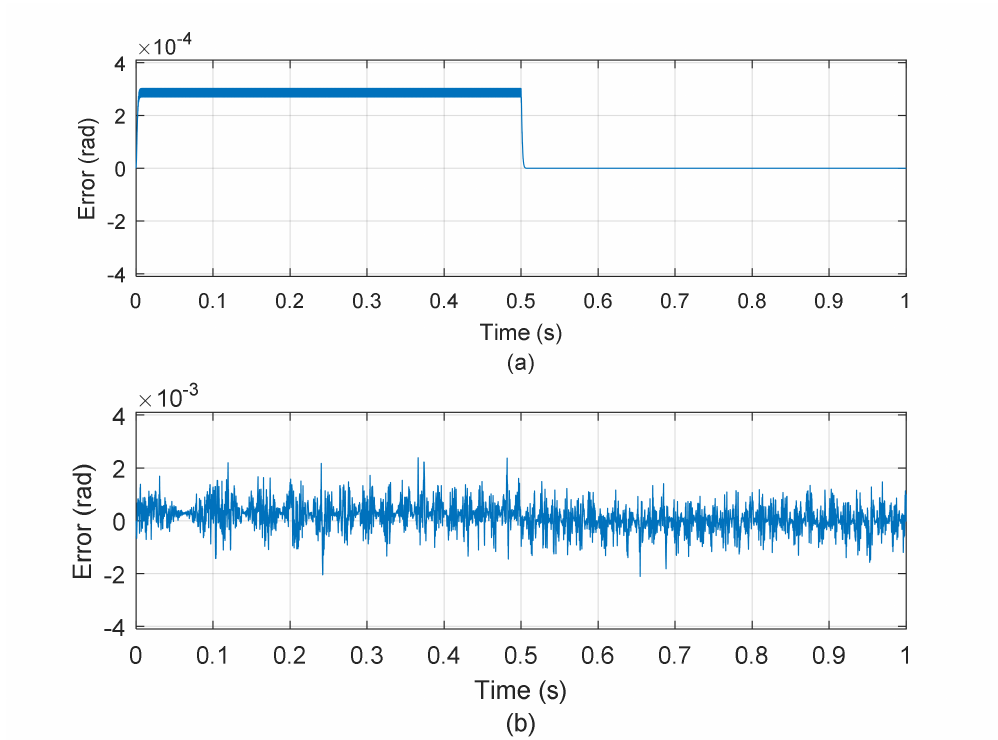
Figure 10. Simulation results for N p = 120, N c = 2, R w = 0.01. ( a ) Without noise; ( b ) with noise.